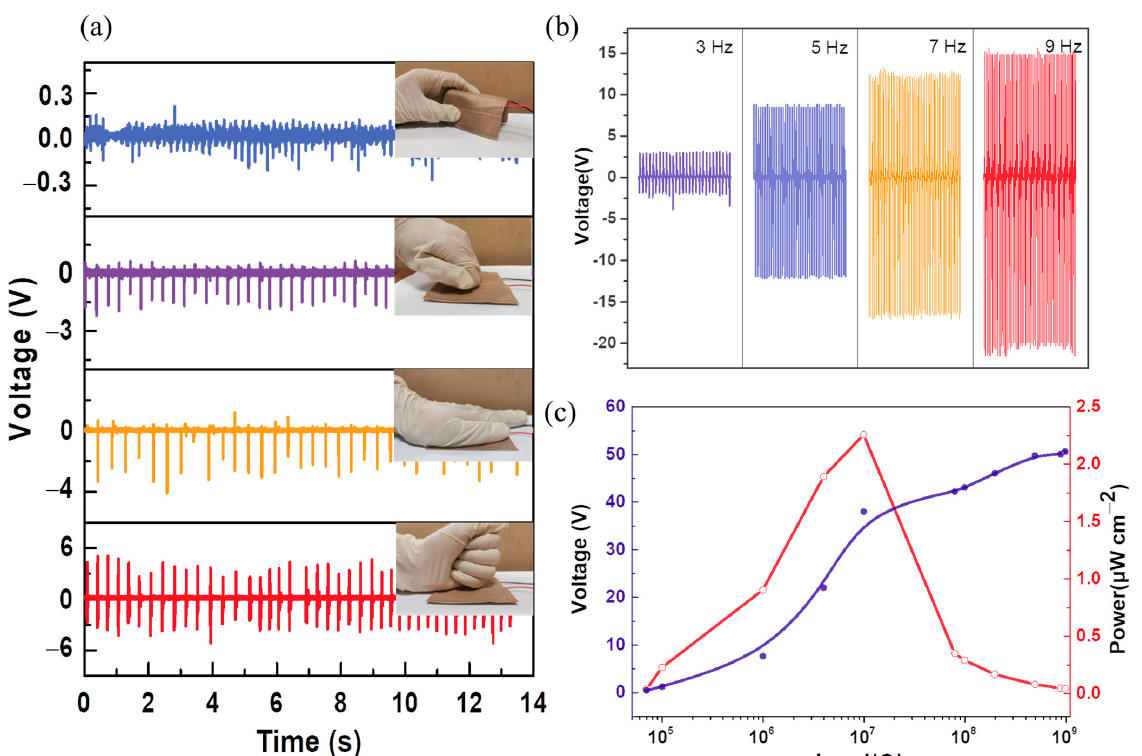
Figure 10. ( a ) Output voltage generated by the PENG under bending, tapping, palm pressing, and fist beating; ( b ) output voltage with frequency; ( c ) output voltage and power across varying re- sistances from the PENG upon exposure to constant force and frequency at 1 N and 1 Hz.